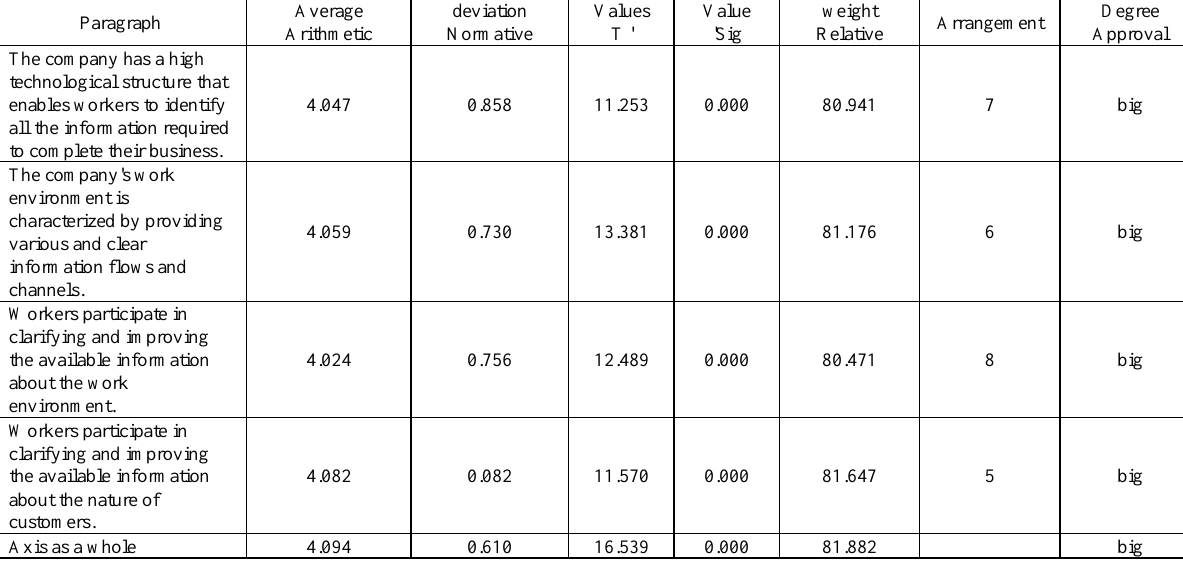
Table 13 (cont.). Analysis of the Paragraphs of the Participation Axis with Information